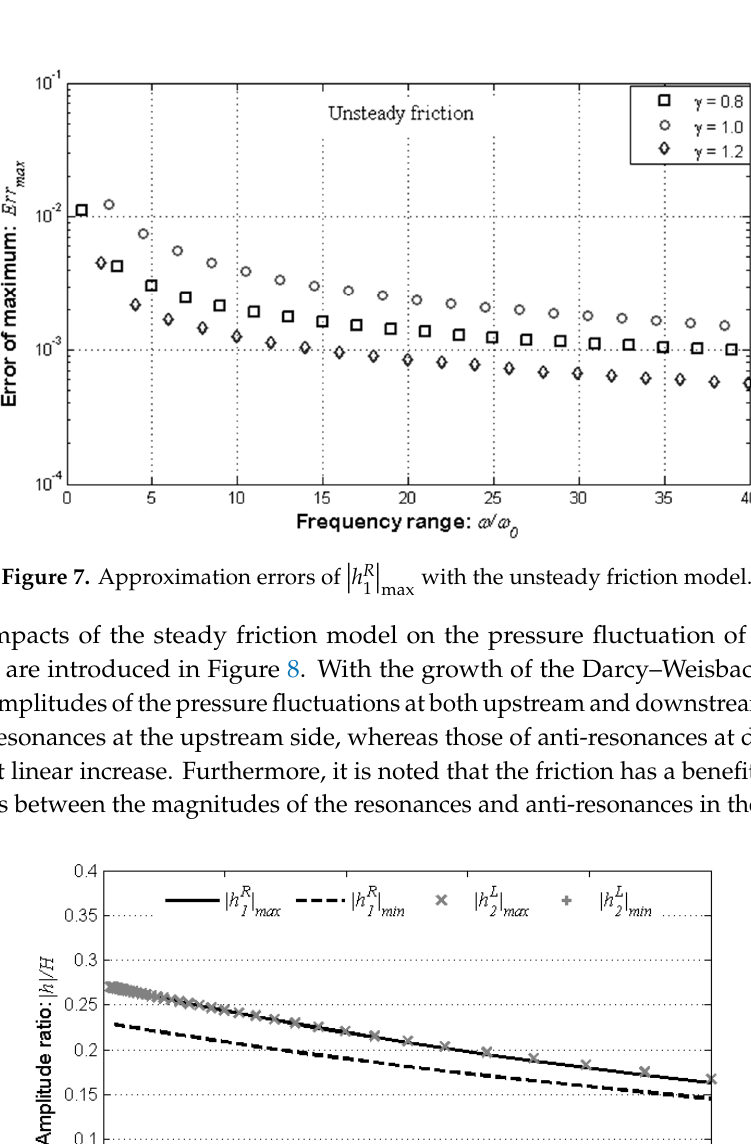
R h with the steady friction model. max